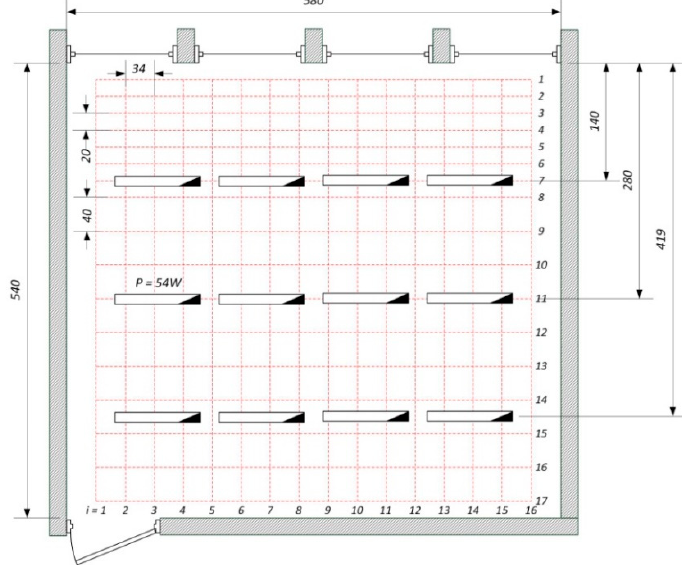
Figure 2. Layout of the laboratory with the arrangement of lamps and measuring grid.